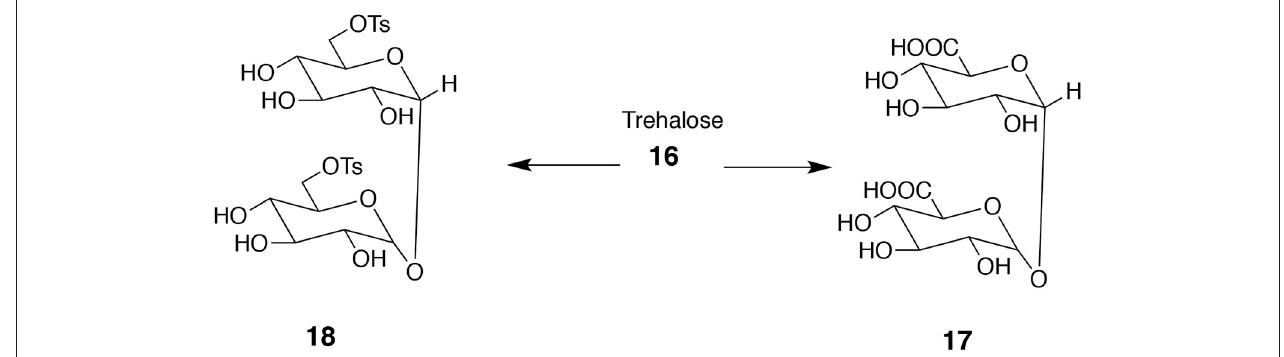
FIGURE 6 | Attractive bifunctional compounds derived from trehalose. The difference in primary and secondary OH groups’ reactivity allows for reacting only the former ones to form diacid 17 or ditosylate 18 .